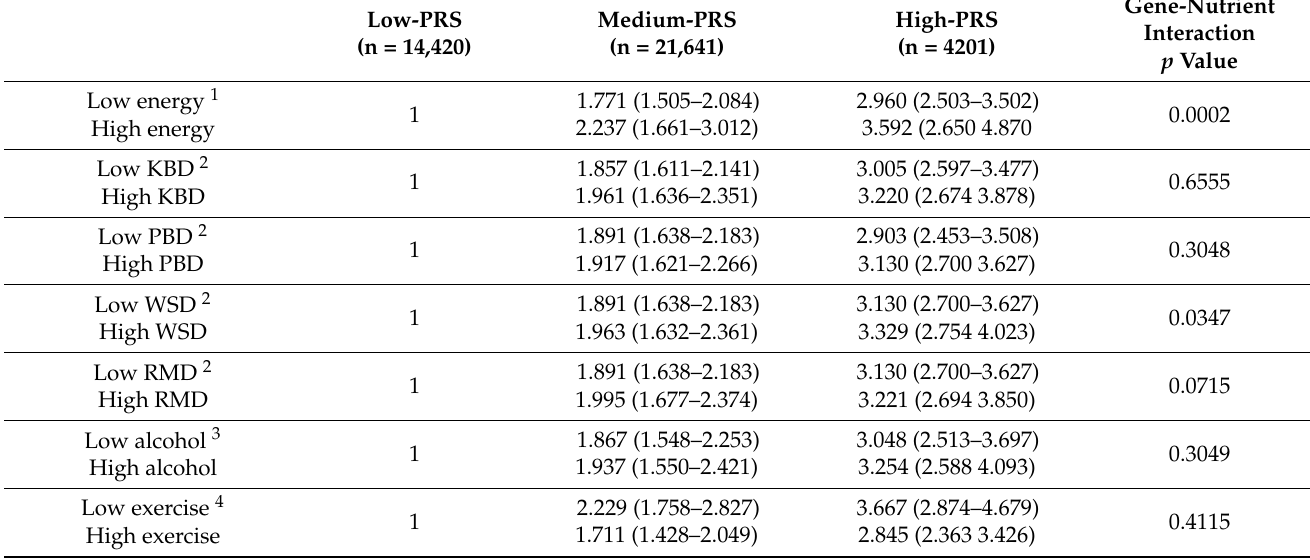
Table 6. Adjusted odds ratios for the T2DM risk by polygenetic risk scores of the best model (PRS) for gene–gene interaction after covariate adjustments according to the lifestyle